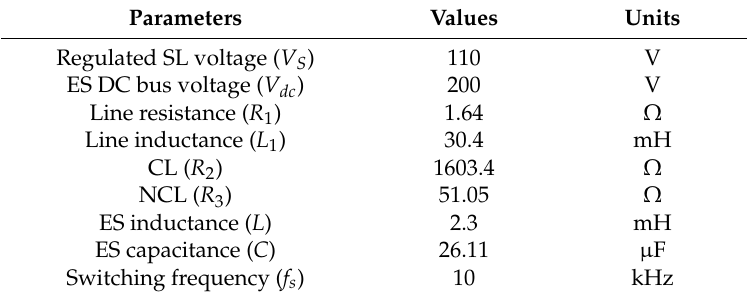
Table 1. The study case data. SL: smart load; ES: Electric springs; CL: critical load; NCL: non-critical load; DC: direct